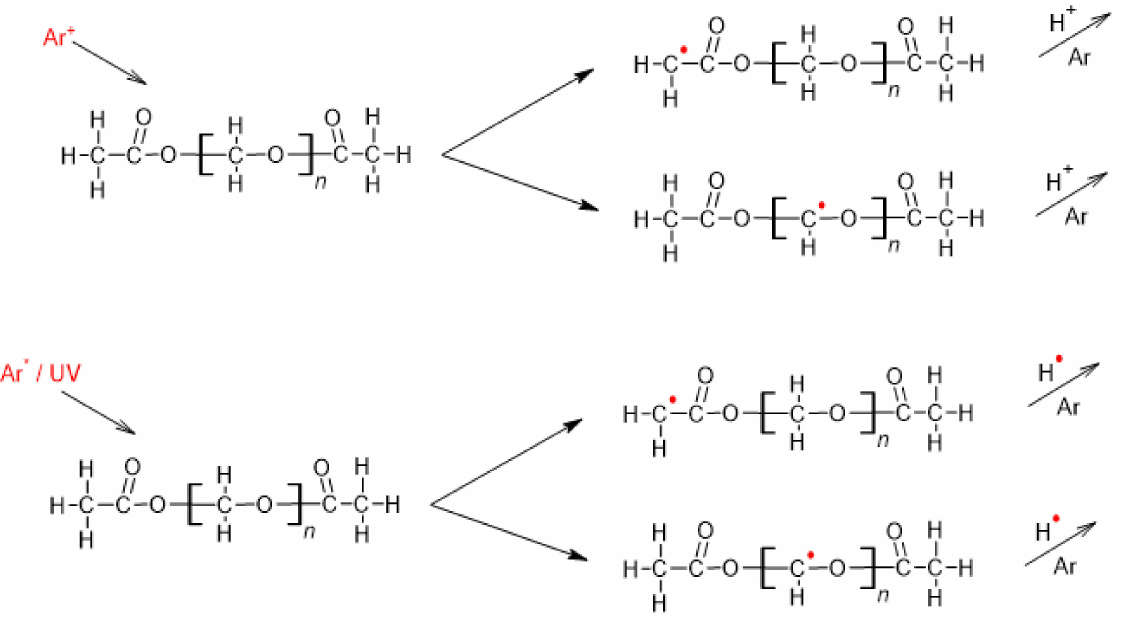
Figure 6. Action of argon plasma on the POM